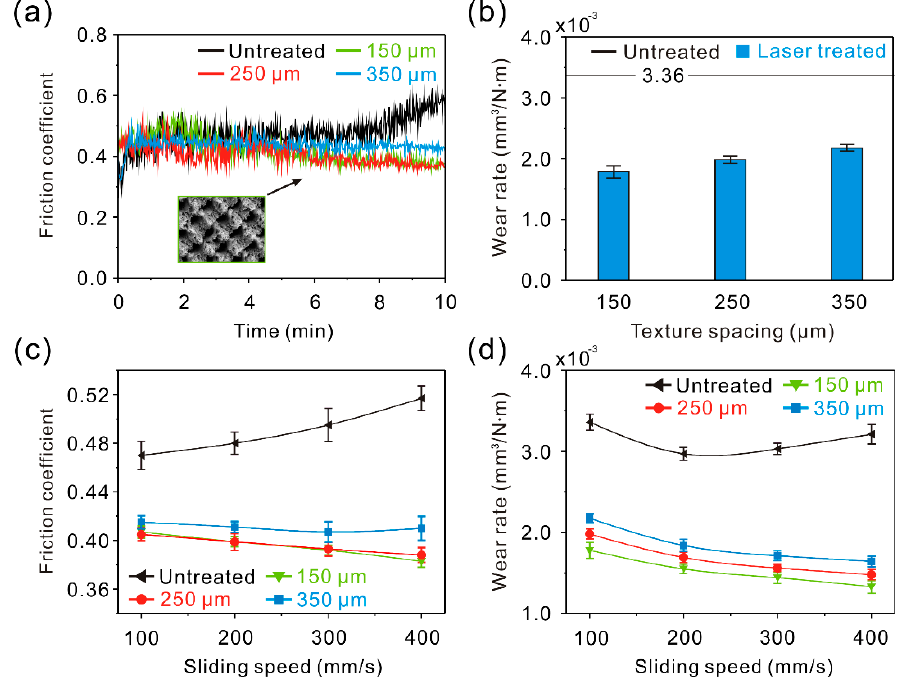
Figure 10. ( a ) Curve of the dynamic friction coefficient of the GGS; ( b ) wear rate of the GGS; ( c ) variation of the friction coefficient of the GGS with sliding speed; ( d ) variation of the wear rate of the GGS with sliding speed (load of 0.3 N, sliding speed of 100 mm/s, frictional pair of GCr15 bearing steel, friction time of 10 min).